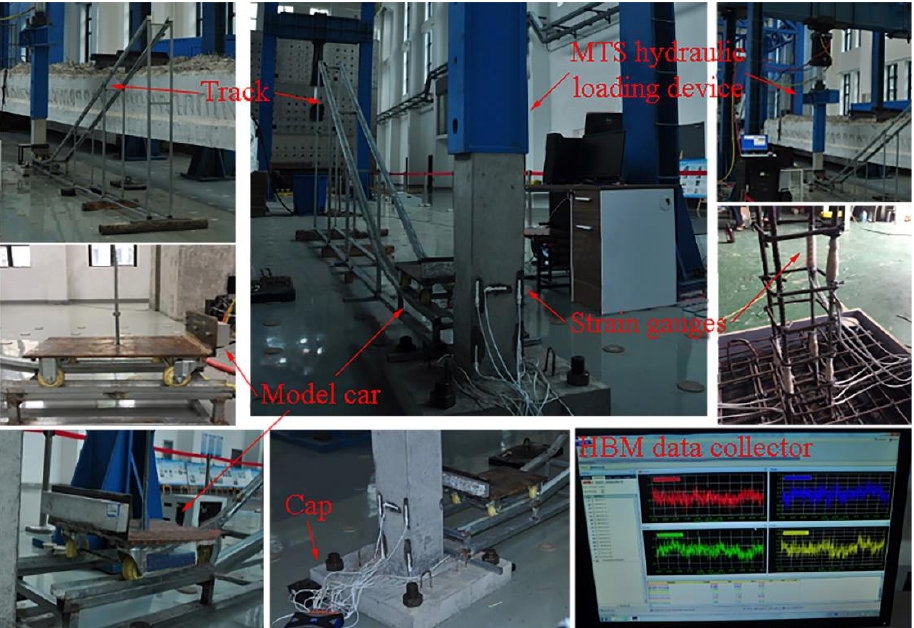
Figure 4. Experimental facility and signal acquisition system.